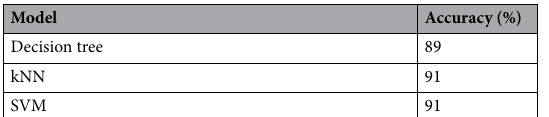
Table 2. The performance of 3 simple machine learning models predicting the binary label, when provided a short vector of engineered cell